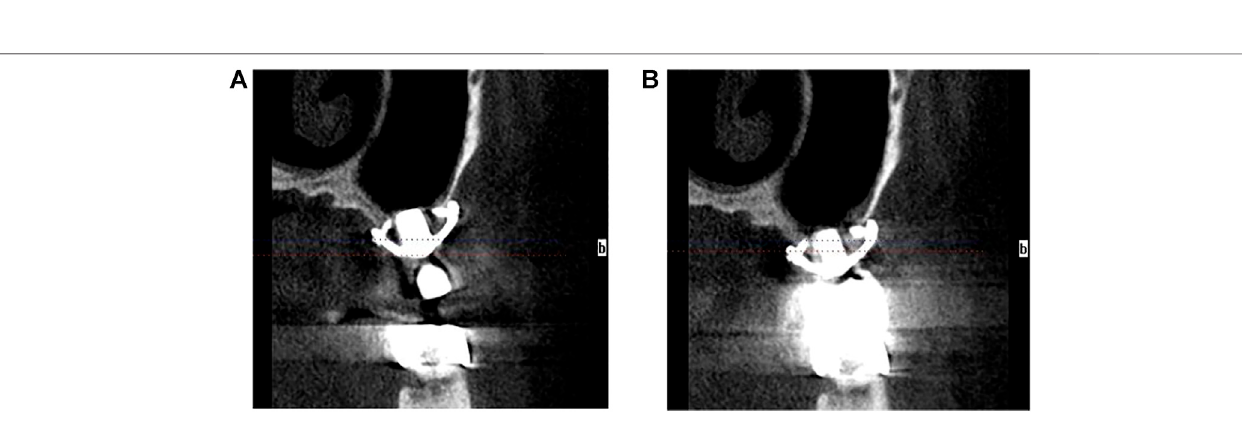
Frontiers in Bioengineering and Biotechnology |